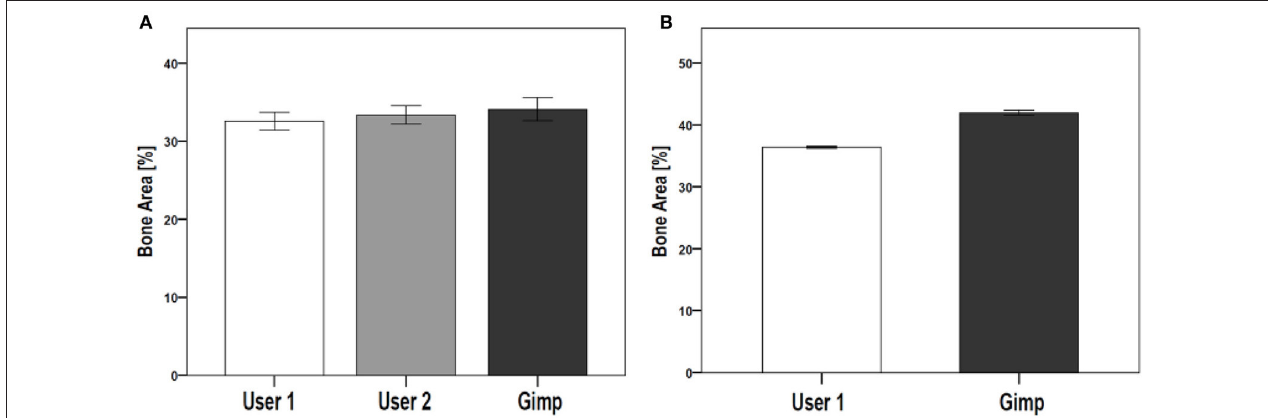
FIGURE 5 | Comparison of TWS results analyzed by two different users and GIMP image analysis software. The reproducibility and validation of generated TWS script was tested by investigating inter-observer differences. (A) Two users were given same set of images to analyze using TWS. Alongside, GIMP based analysis was carried out by one of the user. The analysis was carried out on rat lumbar vertebrae hematoxylin stained sections (data not shown here). No significant differences were seen. (B) The variation in image classification was further tested by giving one image for analysis to a user. The user performed classification using TWS for eight different times. The results showed no large fluctuations in the obtained values. The similar analysis was carried out using Gimp, which showed higher values compared with TWS results. [ N = 9 for (A) , the graphs were plotted as Mean ± Standard error of mean].